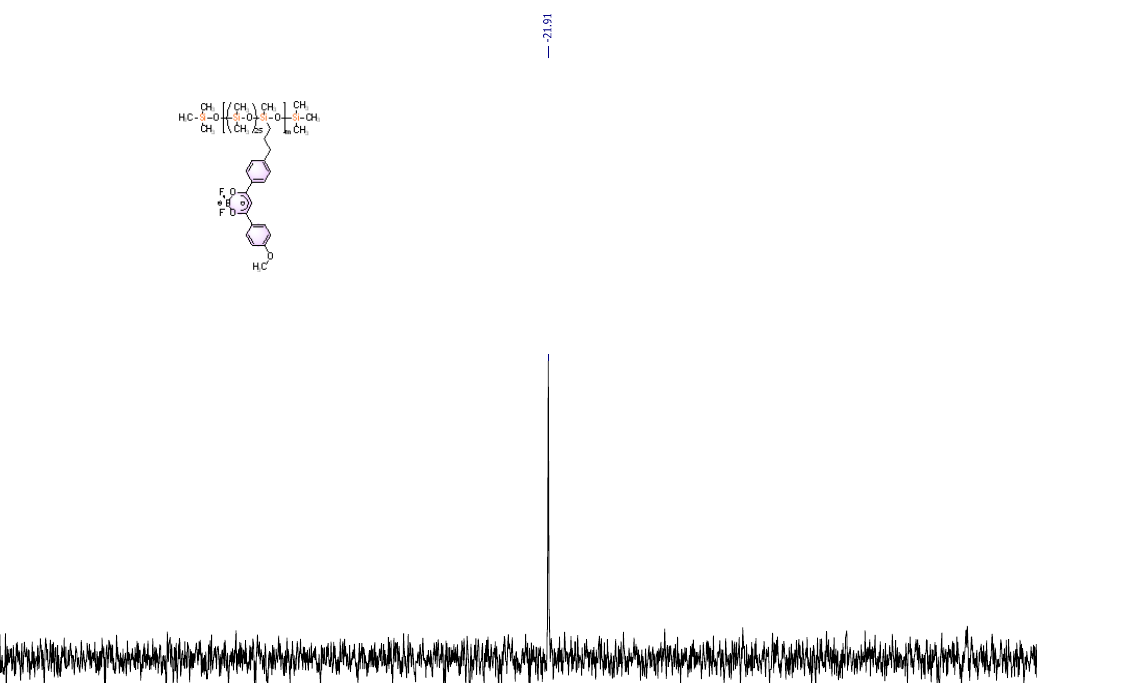
Figure 5. 13 C NMR spectrum of polymer 3 a in CDCl 3 .